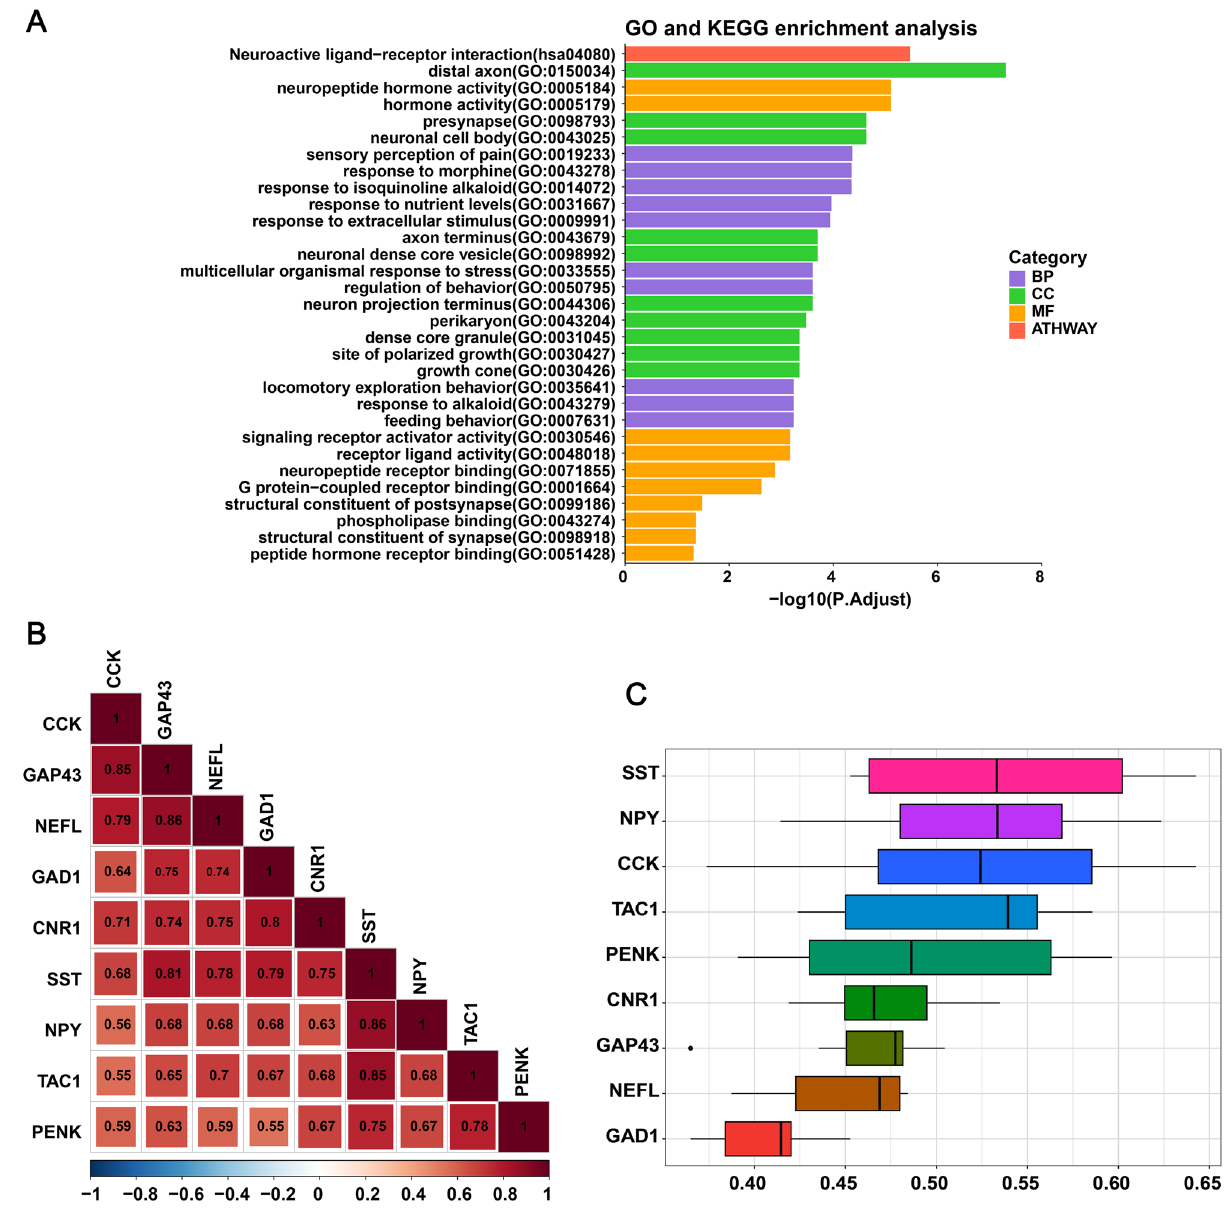
Figure 10. ( A ) Functional enrichment analysis of 9 diagnostic genes. The GO and KEGG enrichment analysis indicated that 9 diagnostic genes were mainly enriched in distal axon, sensory perception of pain, neuropeptide hormone activity, and neuroactive ligand-receptor interaction. ( B ) Correlations analysis of diagnostic genes. There was a positive correlation between genes. Among them, NEFL and GAP43, SST and NPY had the strongest correlation. ( C ) Functional similarity analysis of 9 diagnostic genes. SST had the highest functional similarity factors in oxidative stress and inflammatory immune response and provided new insights for future studies on the molecular mechanisms and therapeutic targets of AD. Further researches are needed to elucidate the clinical application value of biomarkers in AD, and to determine the generalizability of our findings.